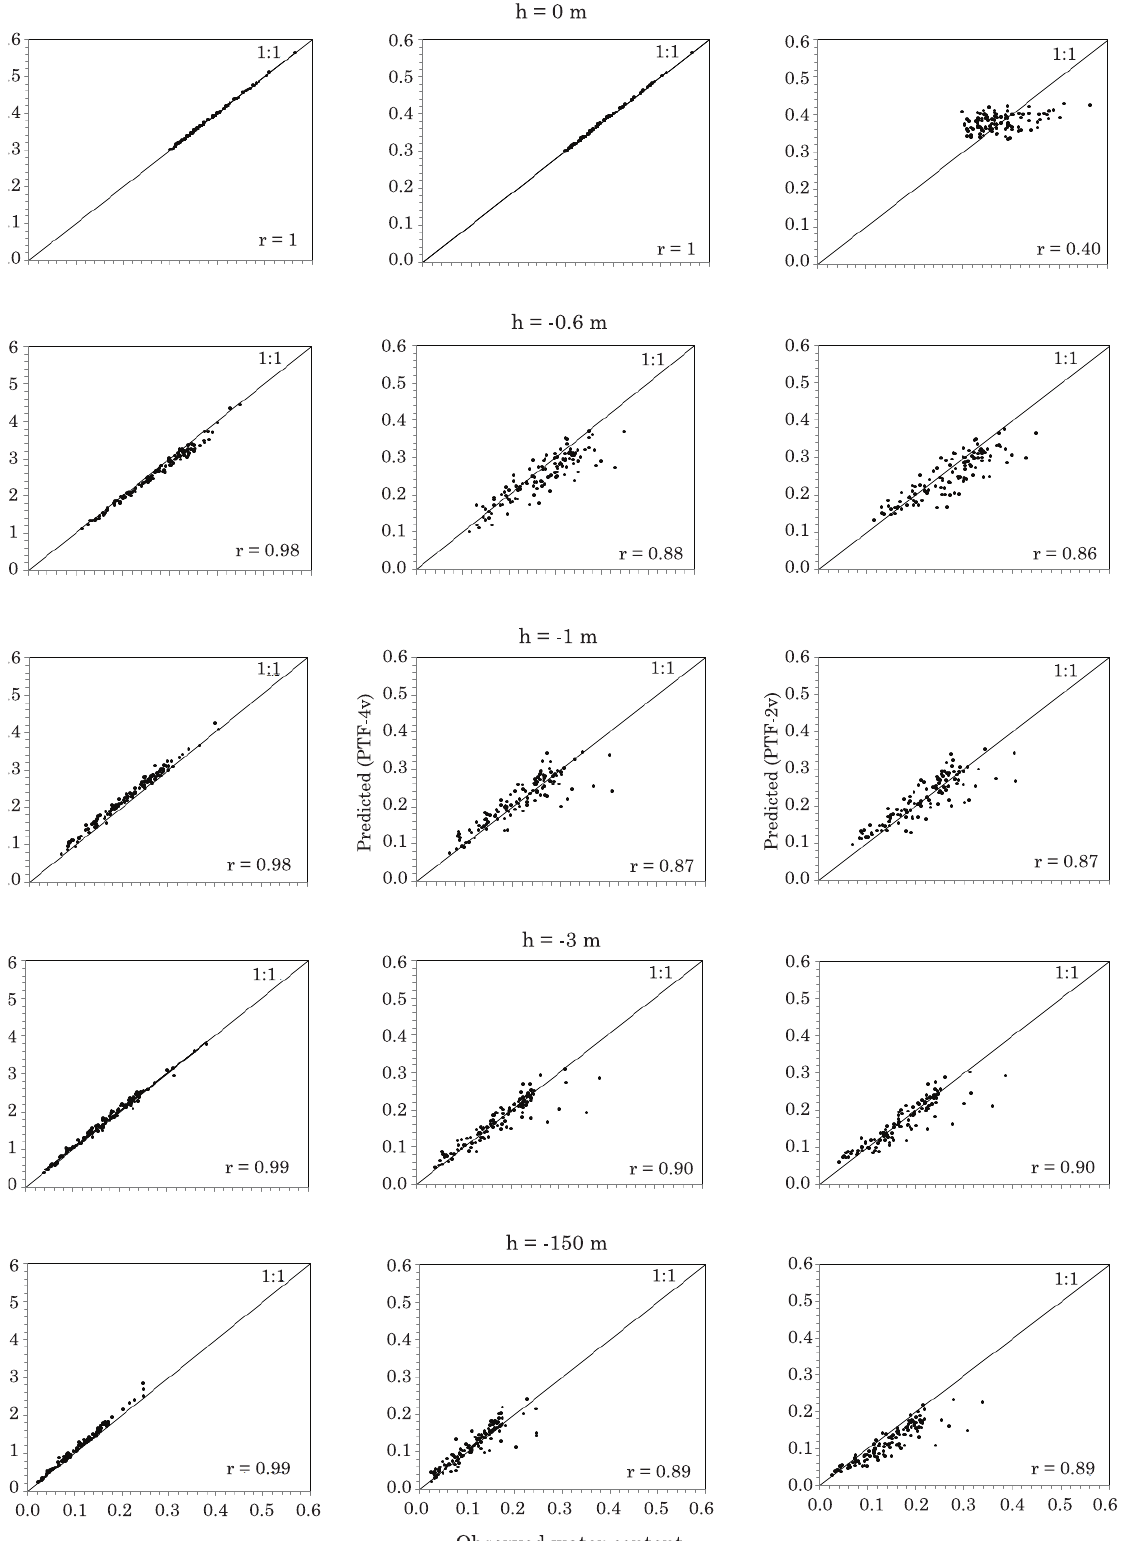
Figure 7. Observed water contents (m 3 m -3 ) at five specific pressure heads versus respective water contents predicted by the original fitted van Genuchten (VG) model (Equation 2) (left column), with VG parameters predicted by PTF- 4v (middle column) and by PTF- 2v (right column) for the validation subset (external